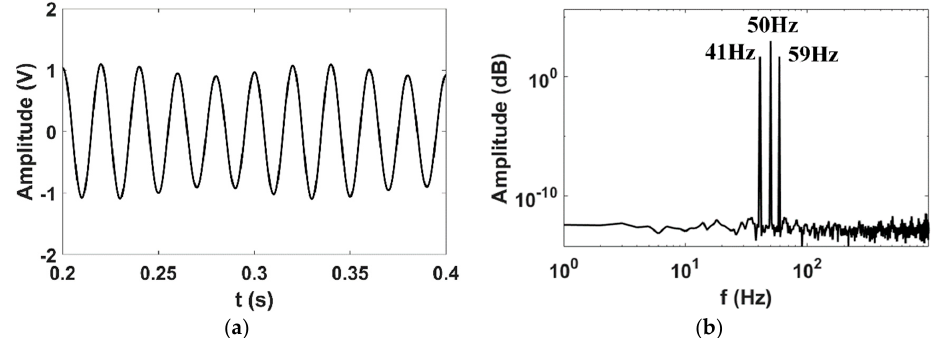
Figure 4. The magnitude and frequency spectrum of the grid voltage, ( a ) magnitude, and ( b ) frequency spectrum.